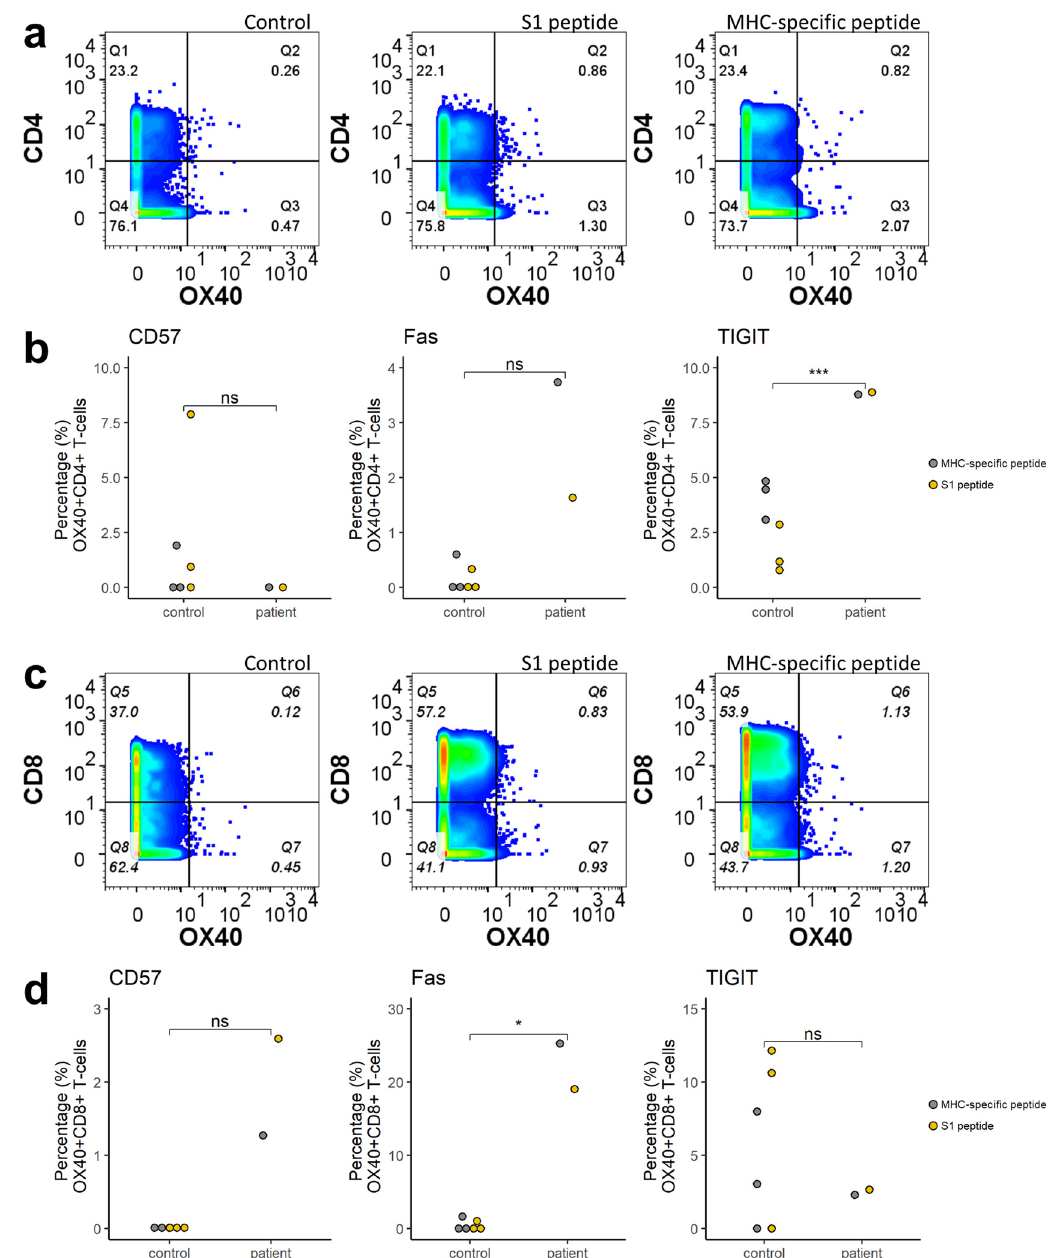
Figure 4. ( a , c ) CD4 + and CD8 + T-cells from the patient displayed upregulation in OX40 expression when stimulated with S1 and MHC-specific peptides compared to unstimulated cells. ( b , d ) Expres- sions of functional markers in antigen-specific OX40 + CD4 + and OX40 + CD8 + T-cells. Significance lev- els analysed by the Mann–Whitney test: ns (not significant) = P > 0.1, * = P ≤ 0.1. MHC: major histo- compatibility complex.